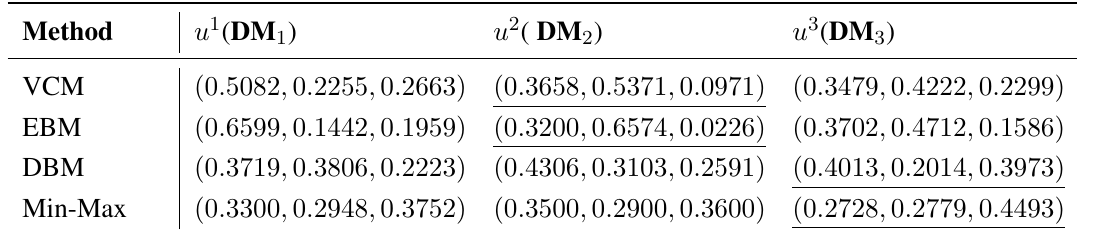
Table 3. Weights of the